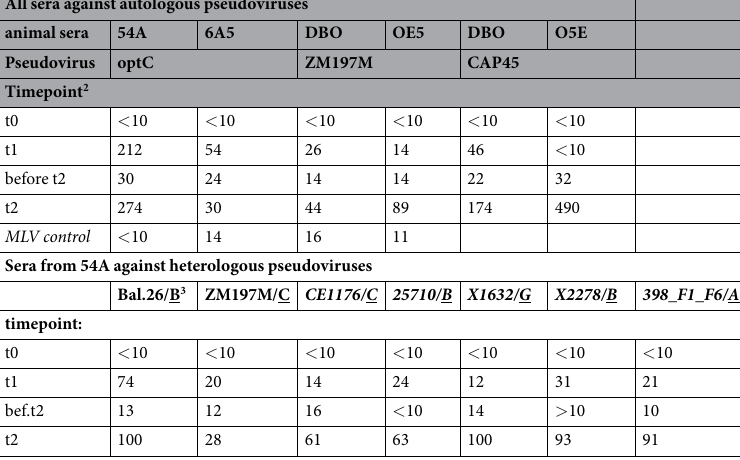
All sera against autologous pseudoviruses